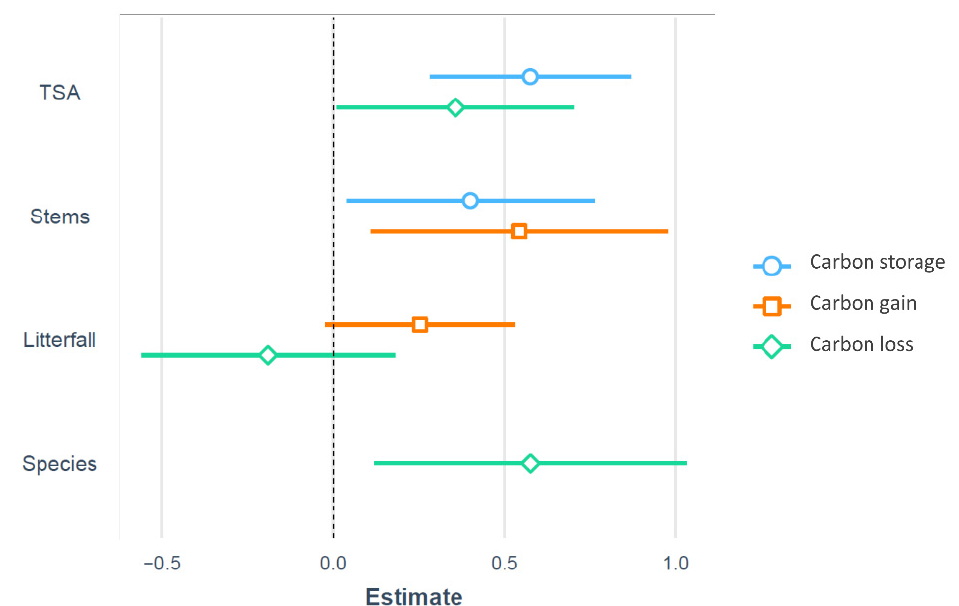
Figure 3. Comparison of the effect of time since abandonment (TSA), averaged annual litterfall per plot, number of species, and stems per plot on carbon storage, carbon gain and carbon loss at both TDF (Mata Seca State Park and Santa Rosa National Park). Standardized regression coefficients can directly be compared among each other; the higher the value, the stronger the relationship observed. If the line crossed the zero, then there was no statistical significance found ( p > 0.001).